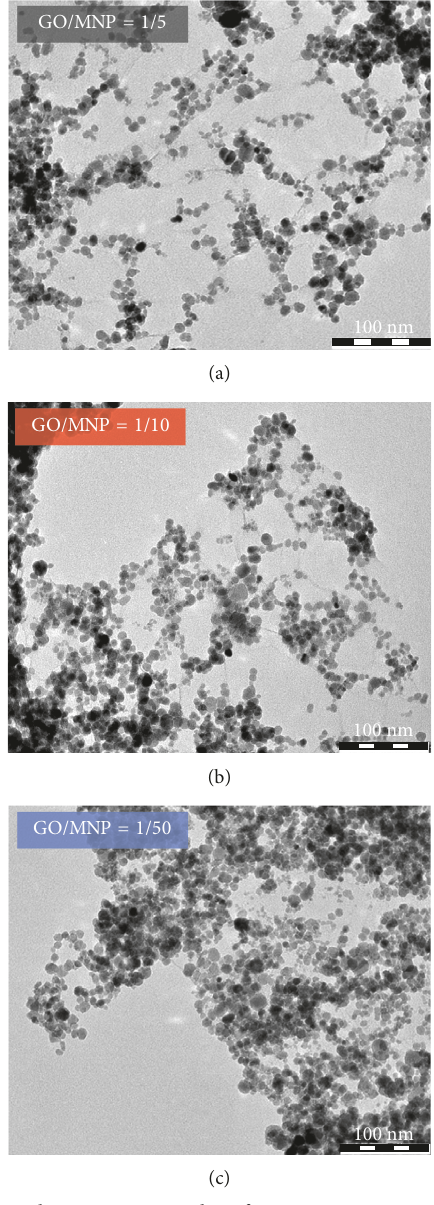
Figure 5: Electron micrographs of magnetic nanocomposites at different GO/MNP mass ratios of (a) 1 to 5, (b)1 to 10, and (c) 1 to 50.